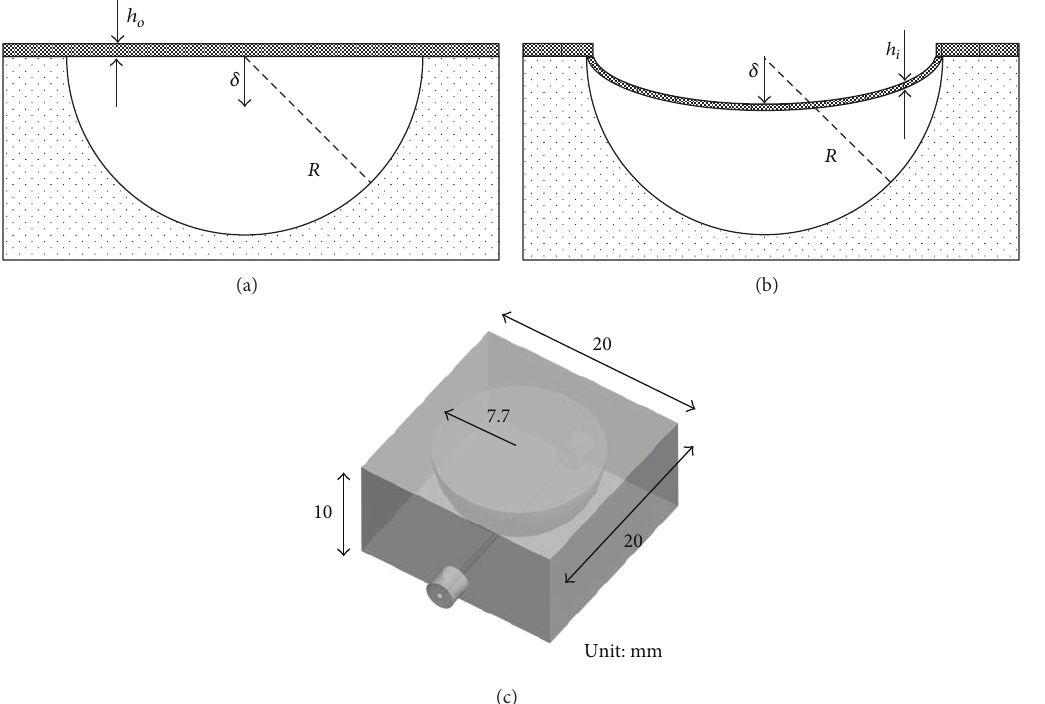
Figure 1: Side view of the modular membrane pump (a) before and (b) while external force is applied. (c) Scheme of the modular pump.